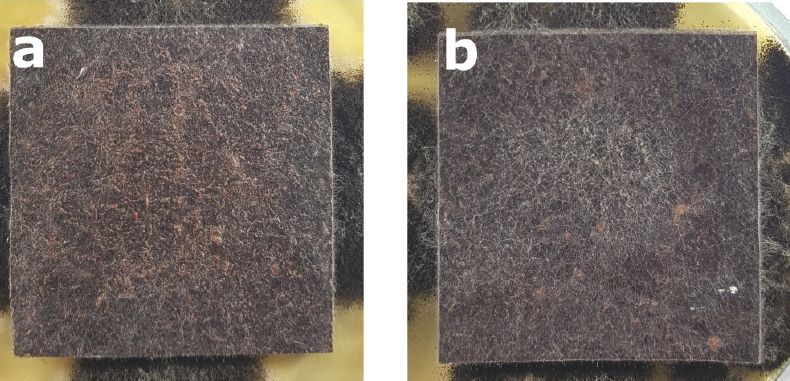
Figure 2. The rate of surface fouling by Aspergillus niger Tiegh fungi on HDPE composites for: ( a ) bark small particles; ( b ) sawdust particles; ( c ) bark large particles; ( d ) sawdust large particles.